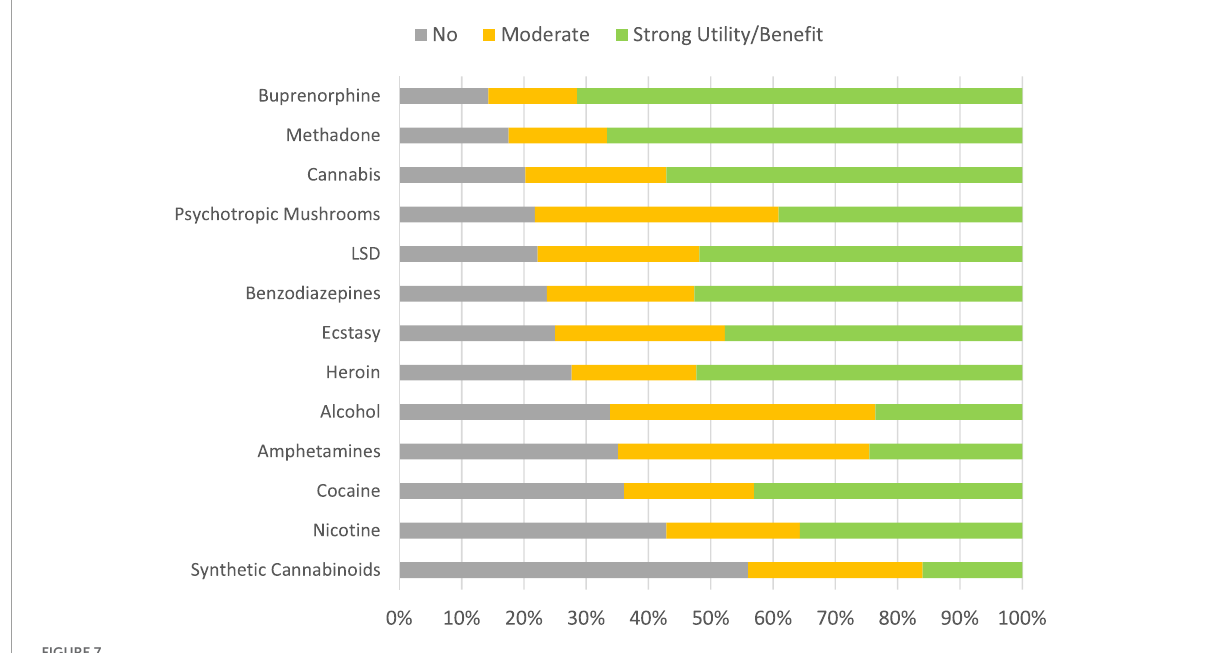
FIGURE7 Distributions of benefits categories (cohort 1). The substances are ranked according to proportions of “no benefit” ratings. Supplementary Figure 21 shows also the ratings for the excluded substances.